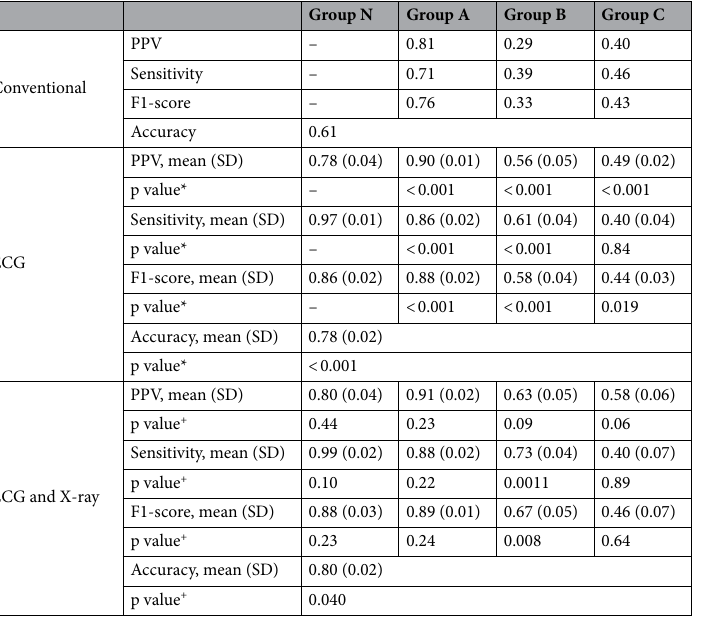
Table 2. Statistics for each algorithm. We analysed the performance of each model. The conventional model was performed once, and the ‘ECG’ and ‘ECG and X-ray’ model was repeatedly performed to analyse the statistics. PPV indicates the positive predictive value; ECG is the abbreviation for echocardiogram. Data are expressed as the mean (standard deviation). The *p value compares the statistics of the conventional algorithm and the deep learning model using only ECG data. The + p value compares the statistics of the deep learning model using only ECGs and the model using both ECG and chest X-ray